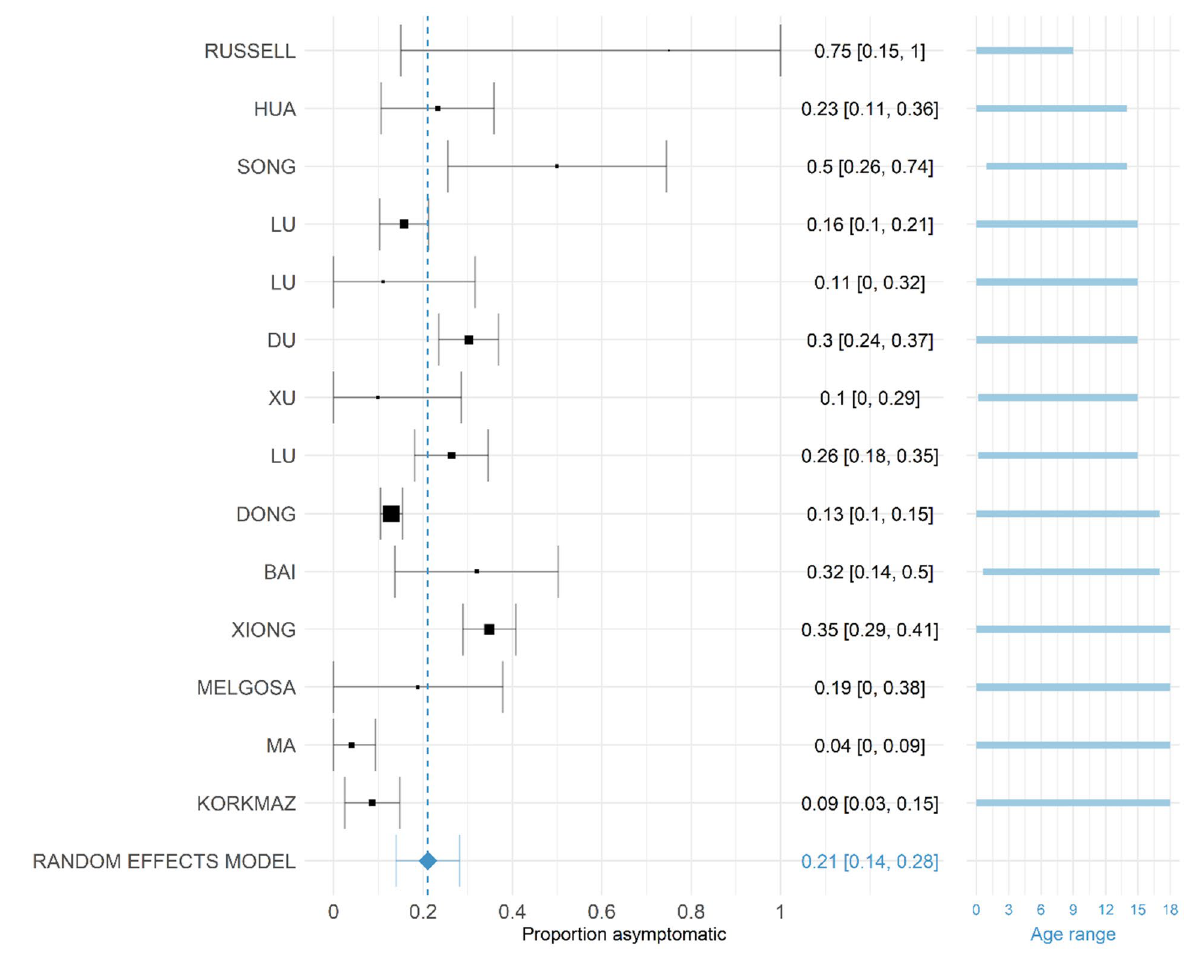
diamond. The squares are proportional in size to the number of COVID-19 positive individuals in the study. All studies were conducted in 2020. The labels on the left provide first author, the labels on the right give point estimate and confidence interval of the asymptomatic proportion estimated. Studies are ordered by the mean of the age range with age range given in blue on the right. Studies were included where recruitment criteria were clear and